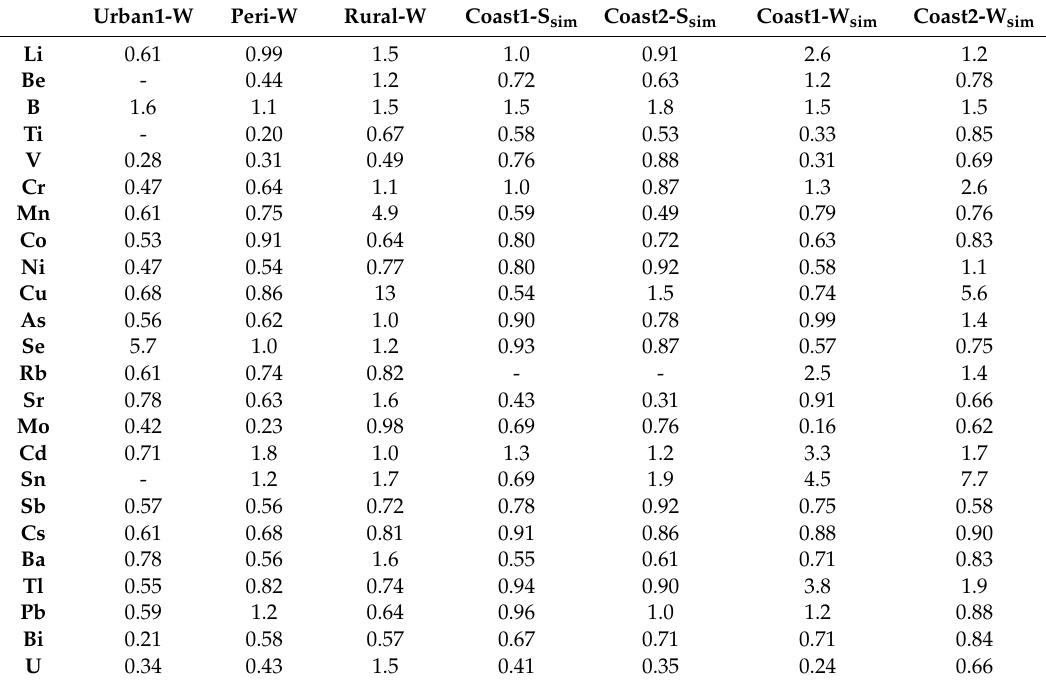
Average indoor-to-outdoor concentration ratios calculated for the extracted micro- and trace-elements.